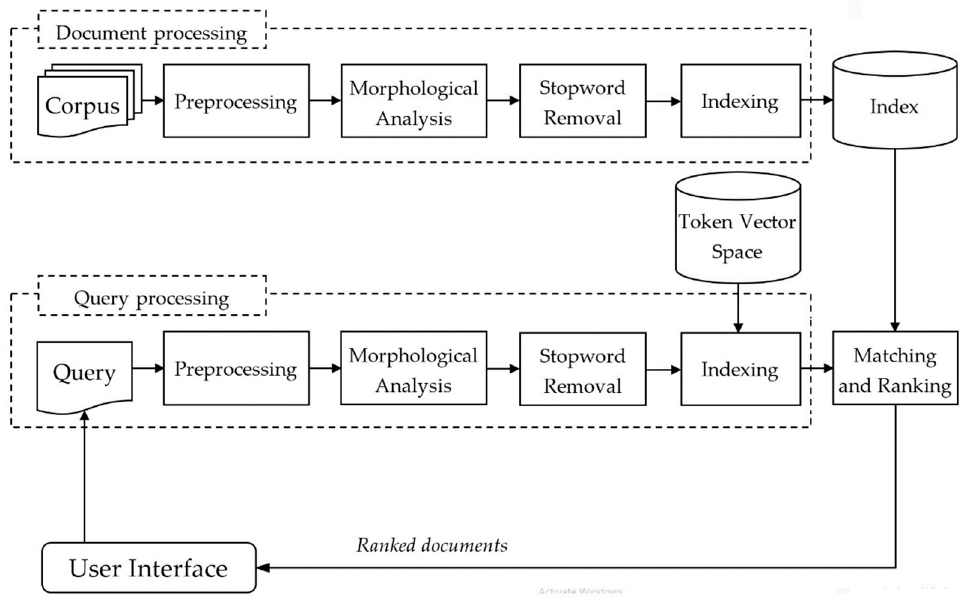
Figure 4. Query expansion architecture using word embeddings for Amharic IR.